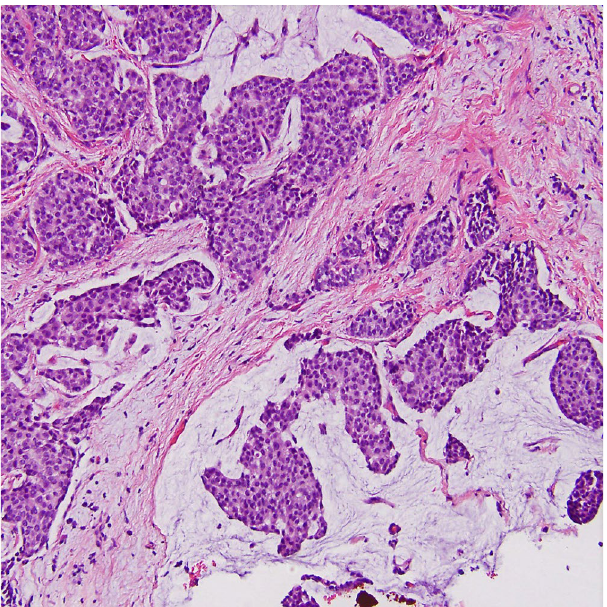
Figure 2. Histopathological image of mixed mucinous breast cancer (MMBC) with presence of invasive ductal carcinoma (IDC) component (grade 2, H&E, original magnification, 200